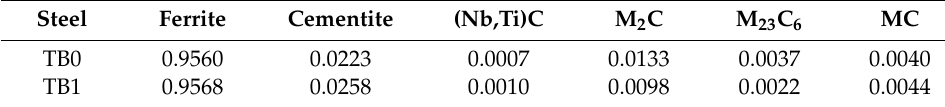
Table 2. Equilibrium phase content of steels after tempering